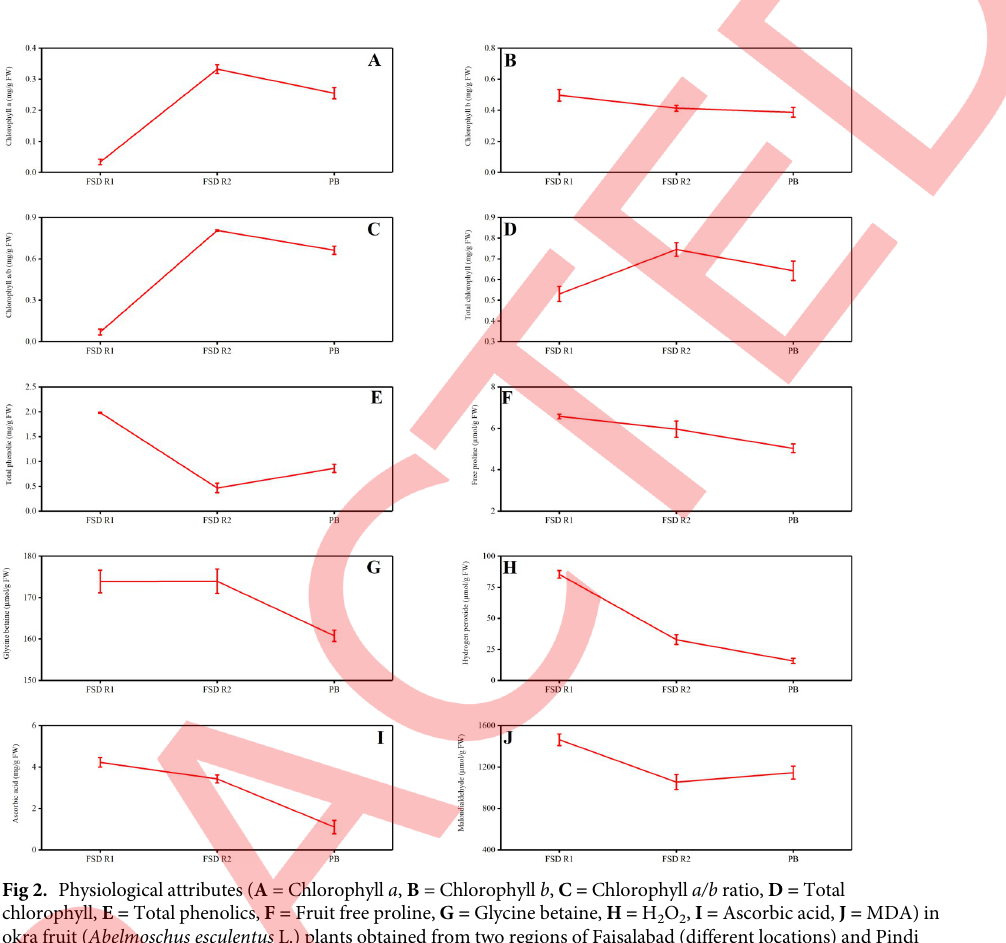
Fig 2. Physiological attributes ( A = Chlorophyll a , B = Chlorophyll b , C = Chlorophyll a/b ratio, D = Total chlorophyll, E = Total phenolics, F = Fruit free proline, G = Glycine betaine, H = H 2 O 2 , I = Ascorbic acid, J = MDA) in okra fruit ( Abelmoschus esculentus L.) plants obtained from two regions of Faisalabad (different locations) and Pindi Bhattian.